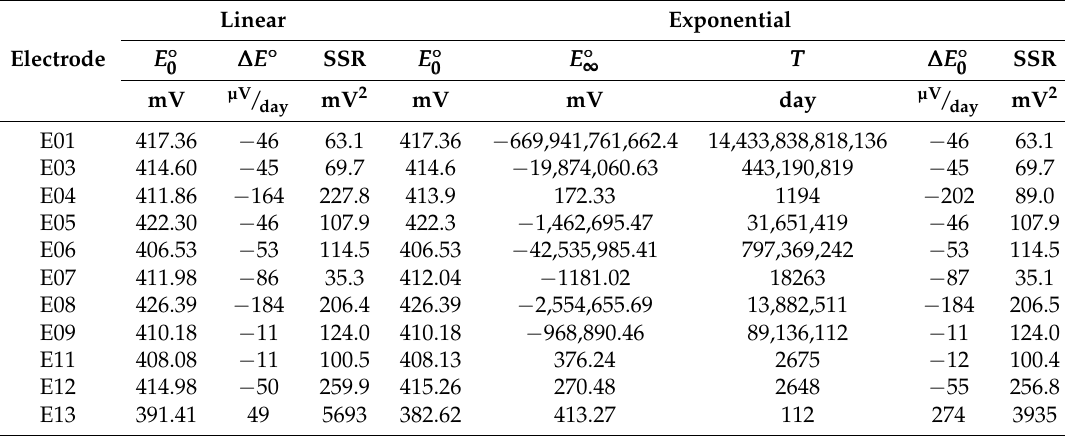
Table 3. Drift parameters of electrode standard potential approximated using linear or exponential equations. E ◦ , initial value; ∆ E ◦ , daily change; SSR, the sum of squares of residuals; E ◦ ∞ , final value; 0 T E ◦ , time constant; ∆ E ◦ , initial daily change. 0 Linear Exponential